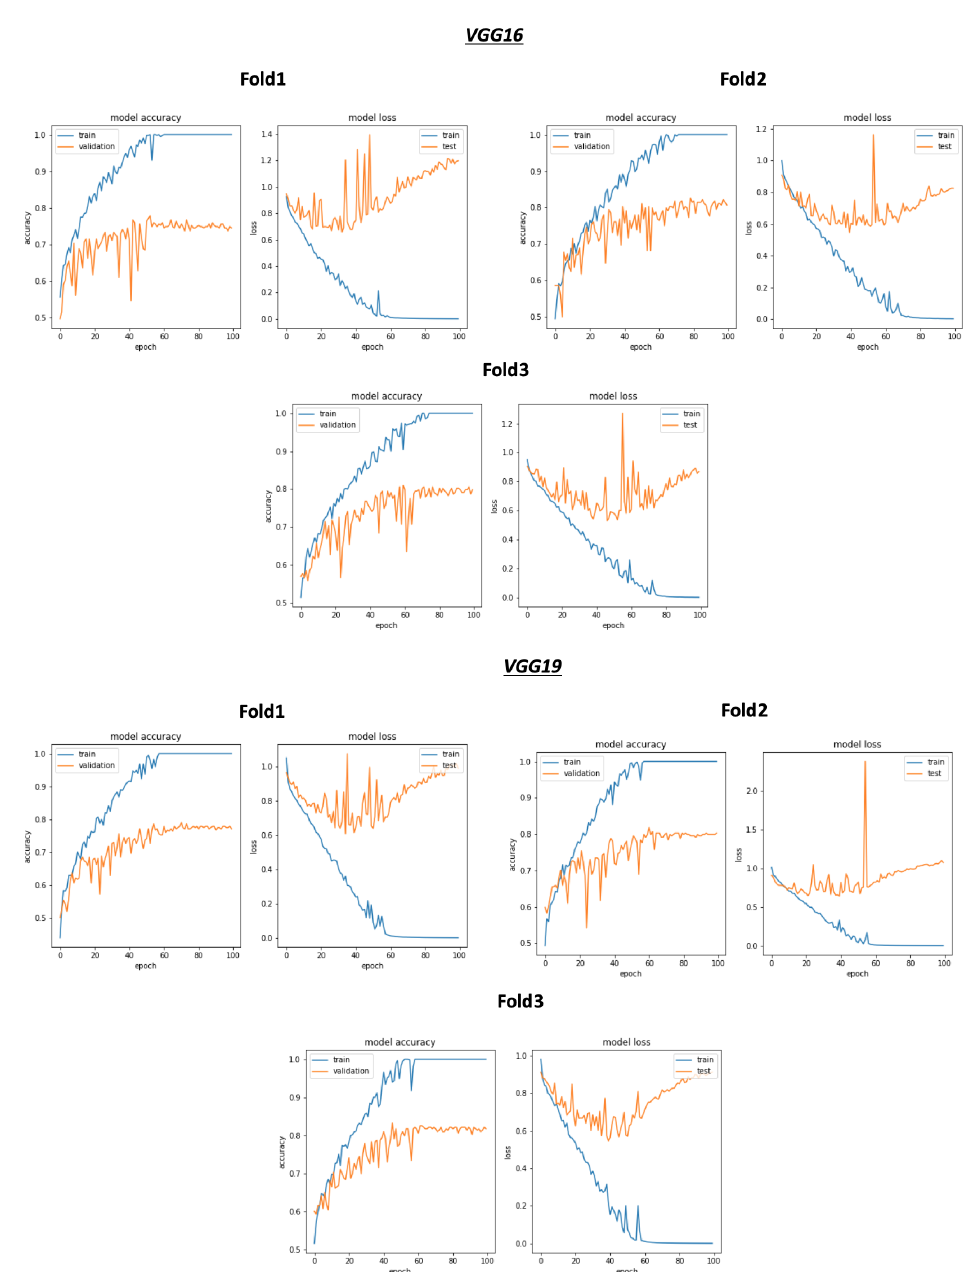
Figure 8. Overview of CNN VGG16-VGG19 validation accuracy curve without selection